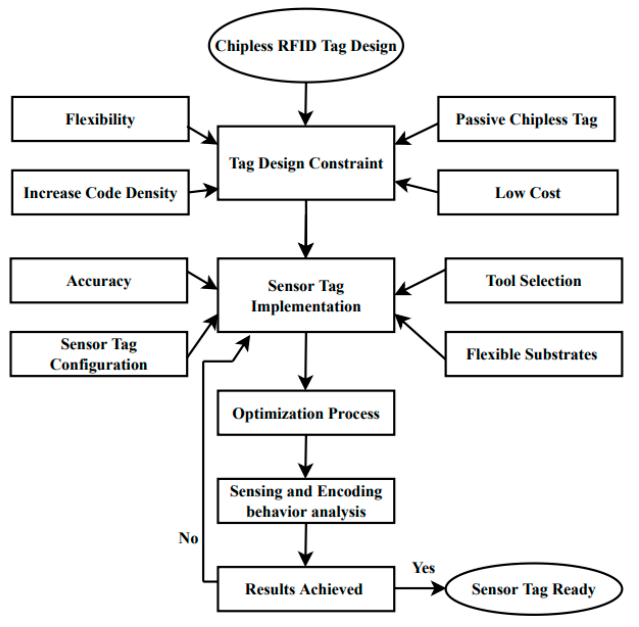
Figure 2. Flow chart.